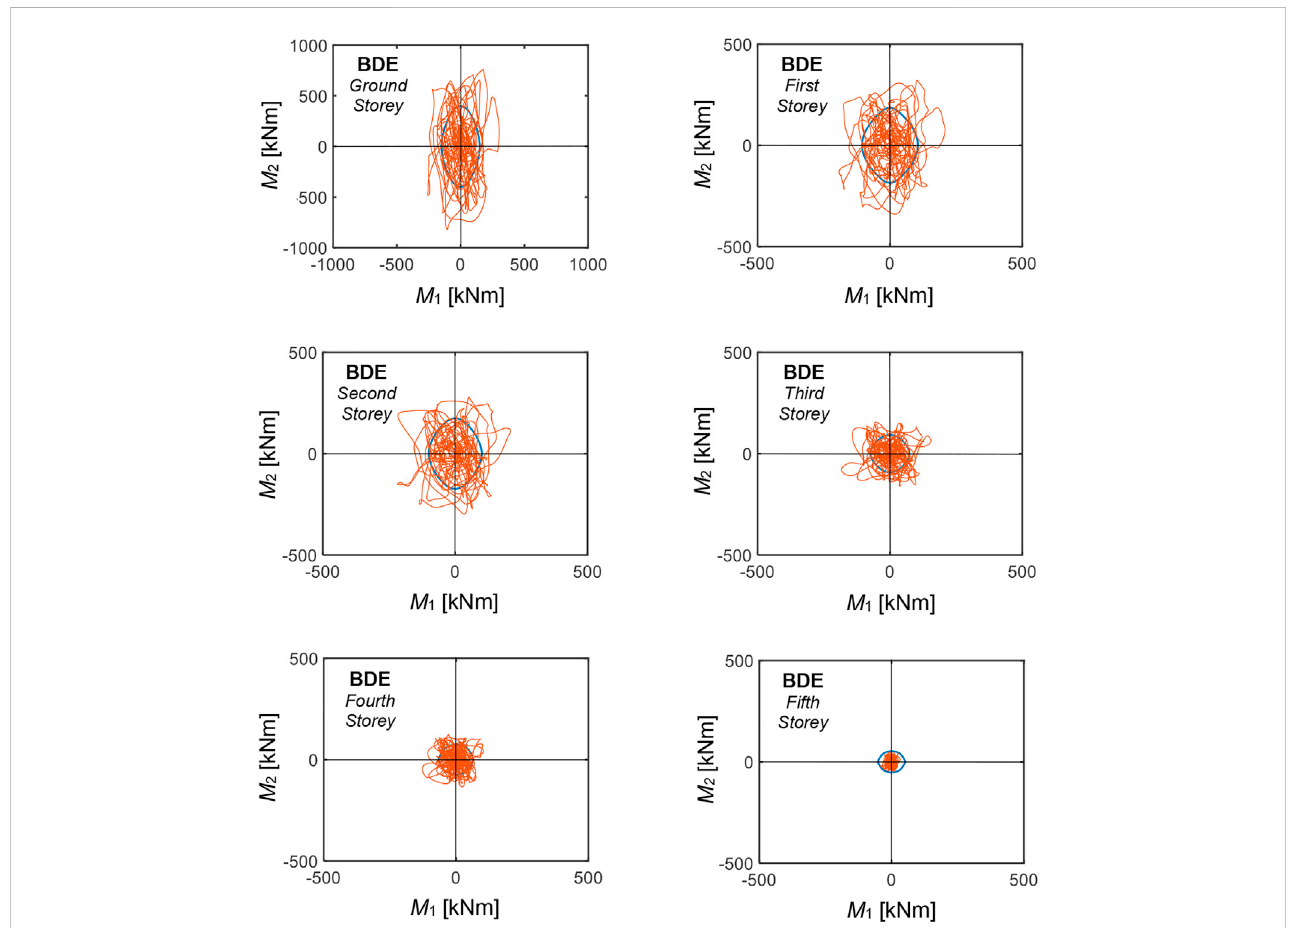
FIGURE 6 M 1 – M 2 biaxial moment interaction curves (red lines) for the columns belonging to the 3/B vertical fi xed line obtained from the most demanding BDE- scaled group of input accelerograms, and relevant safe domains (blue lines).